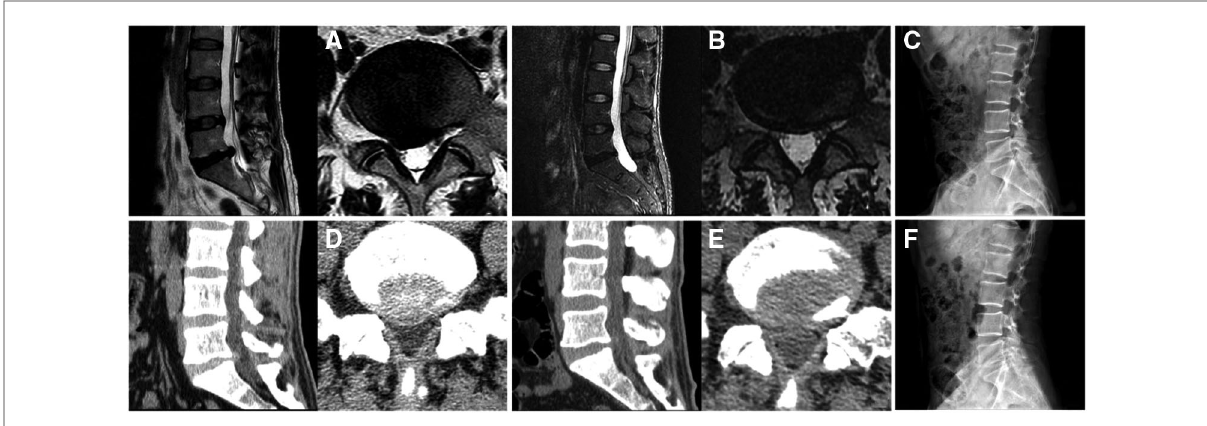
FIGURE 4 Images of a patient who underwent percutaneous endoscopic lumbar discectomy via the medial foraminal approach. ( A ) A right L5 – S1 disc herniation is shown on preoperative magnetic resonance imaging. ( B ) Postoperative imaging shows removal of the herniated disc and preservation of the annulus fi brosus. ( C ) Preoperative lateral plain radiography of the lumbar spine. ( D ) L5 – S1 disc herniation on preoperative computed tomography. ( E ) Postoperative computed tomography shows disappearance of the herniation and preservation of the ligamentum fl avum. ( F ) Postoperative lateral plain radiography of the lumbar spine.